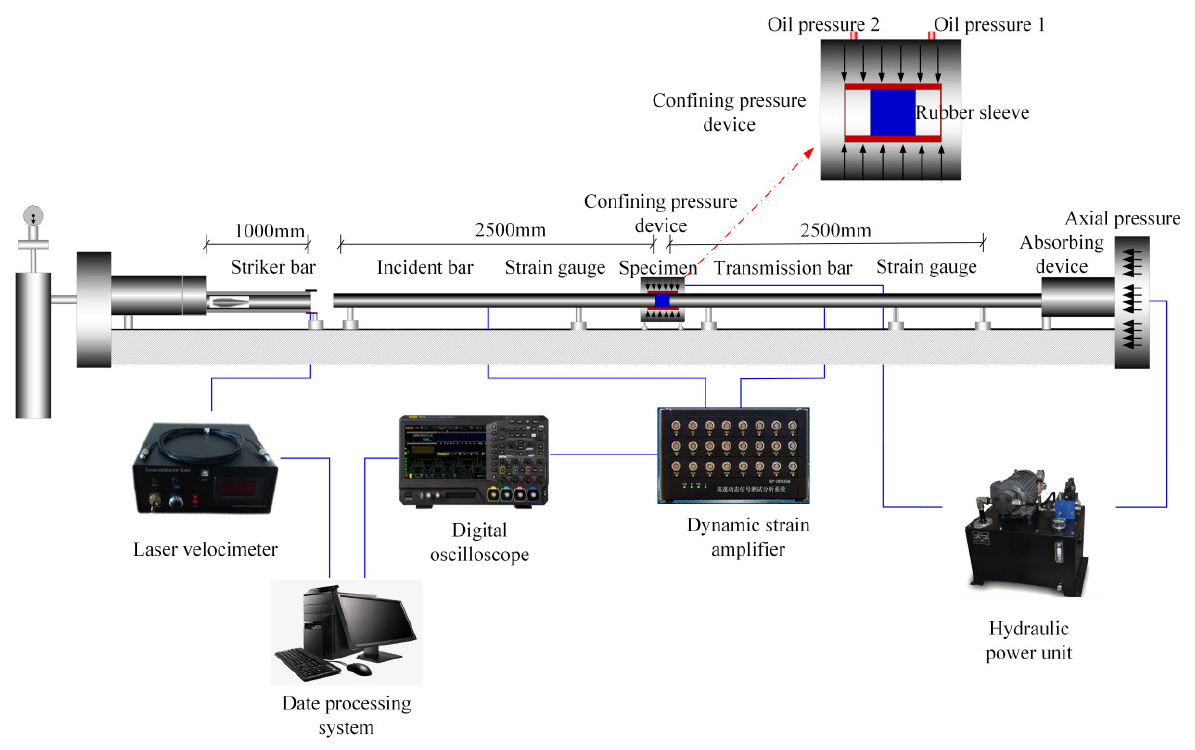
Figure 2. Three-dimensional SHPB test system.